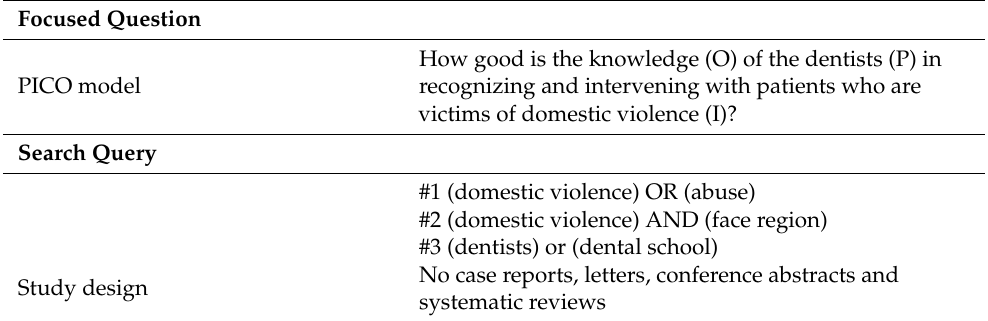
Table 1. PICO model as defined by the McMaster University of Chicago